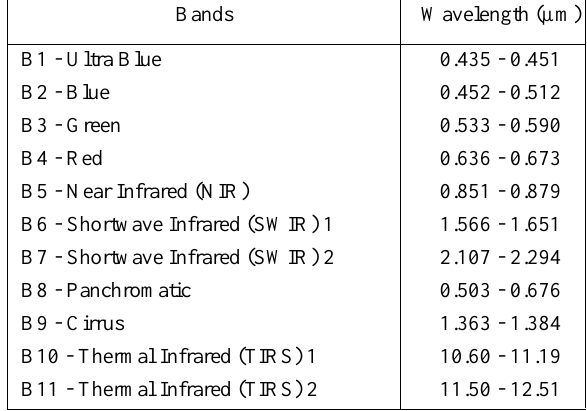
Table 1: Landsat-8 OLI satellite bands